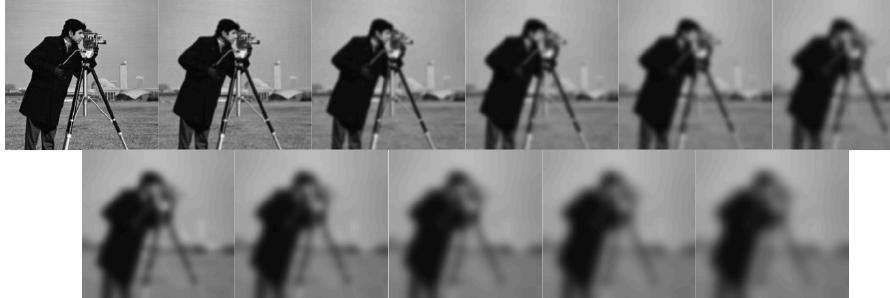
Figure 16. “Cameraman” with increasing blur.